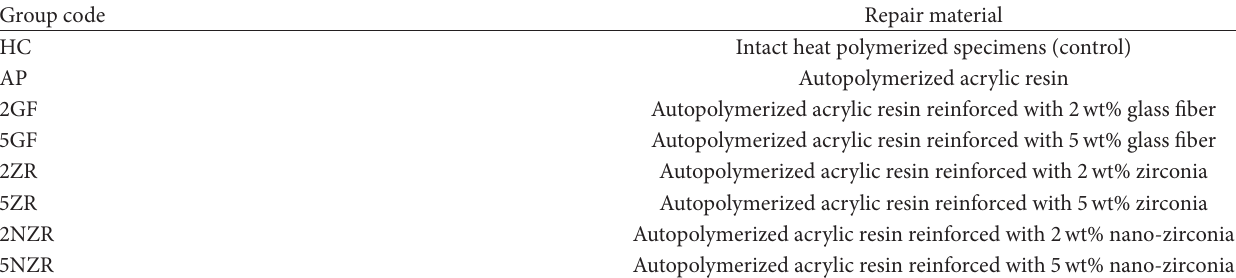
Table 1: Tested groups and coding according to repair material